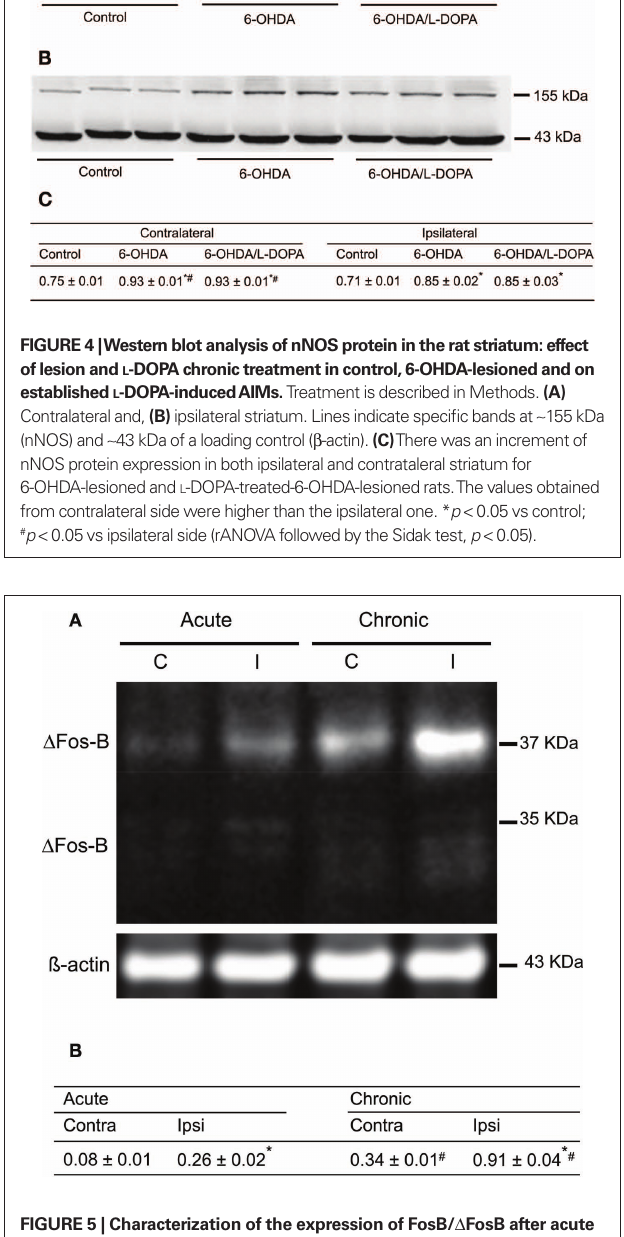
Figure 5 | Characterization of the expression of FosB/ ∆ FosB after acute and on established l -DOPA-induced AiMs. (A) Western blots of proteins from extracted striatum of acutely and chronically l -DOPA-treated hemiparkinsonian rats; left and right lanes represent proteins from ipsilateral (I) and contralateral (C) striatum, respectively. (B) Results of the quantification of l -DOPA-induced FosB/ ∆ FosB expression are expressed as the integrated density of each band of the proteins of interest was normalized to the integrated density of the control loading ß-actin (mean ± SEM; square pixel). * p < 0.05 compared with contralateral striatum for either acute or chronic treatment with l -DOPA (paired t -test). # p < 0.05 compared with the same side for acute or chronic treatment with l -DOPA ( t